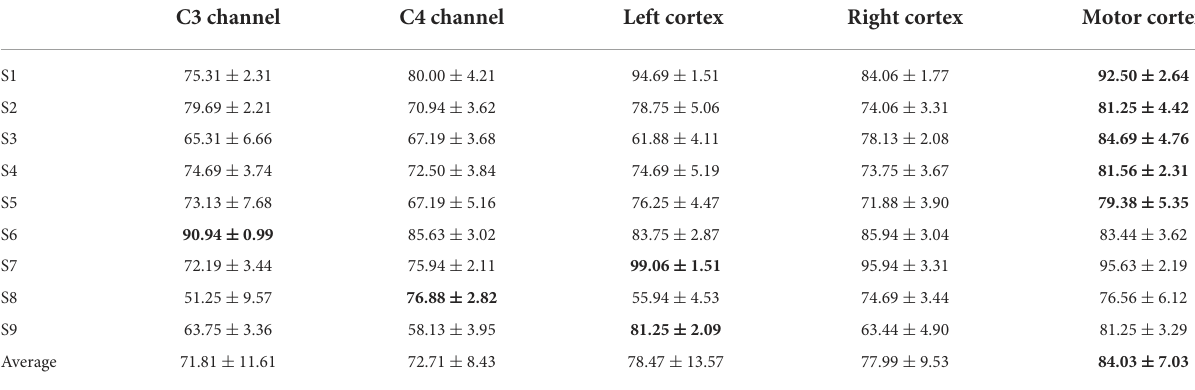
TABLE 7 The LDA model performance of clustered feature based on different channel selection in griping vs. opening classification.